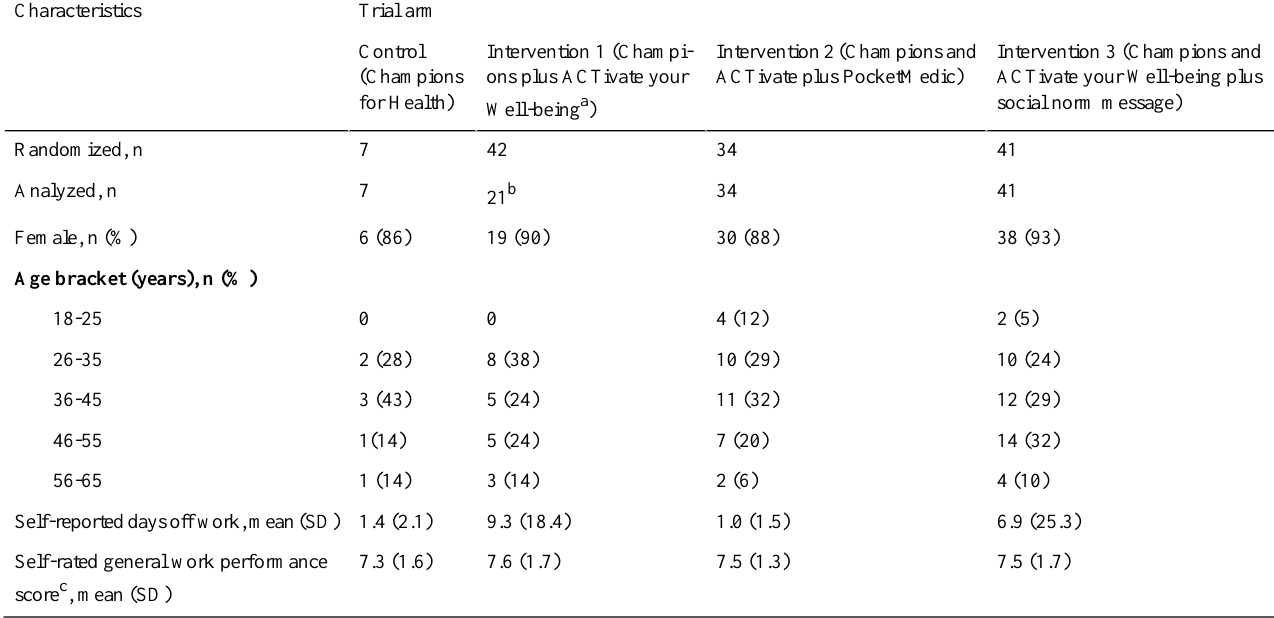
Trial armCharacteristics